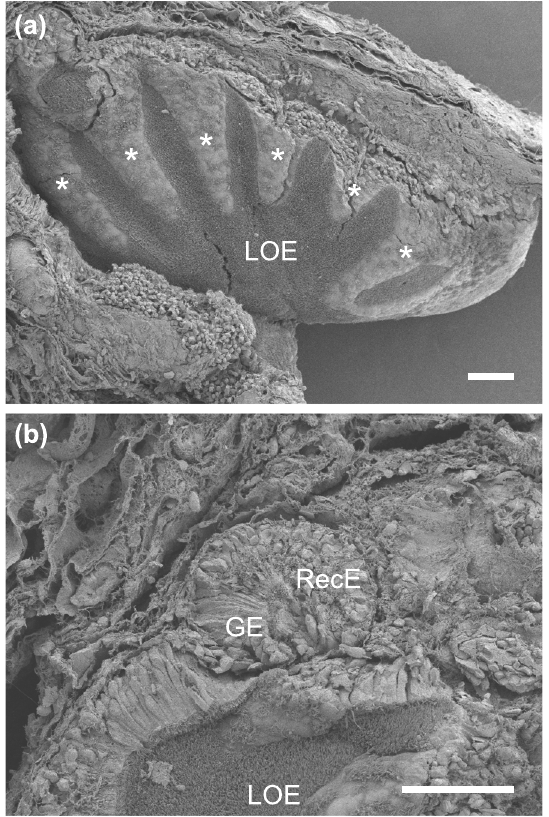
Fig. 2 Scanning electron microscopy of a lamella cut out from the olfactory organ of P. aethiopicus . ( a ) Surface of the lamella covered with the non-sensory epithelium (asterisks) and lamellar OE (LOE). ( b ) Higher magnification view of a recess at the base of lamella consisting the recess epithelium (RecE) and glandular epithelium (GE). Scale bars: 100 µm